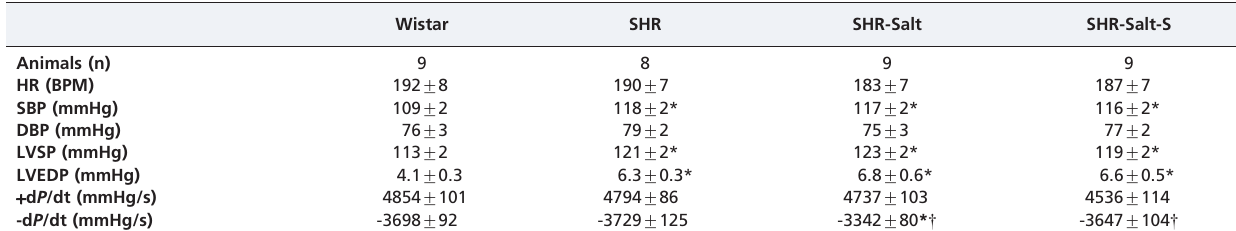
Table 2 - Hemodynamic parameters observed in anesthetized animals after eight weeks of